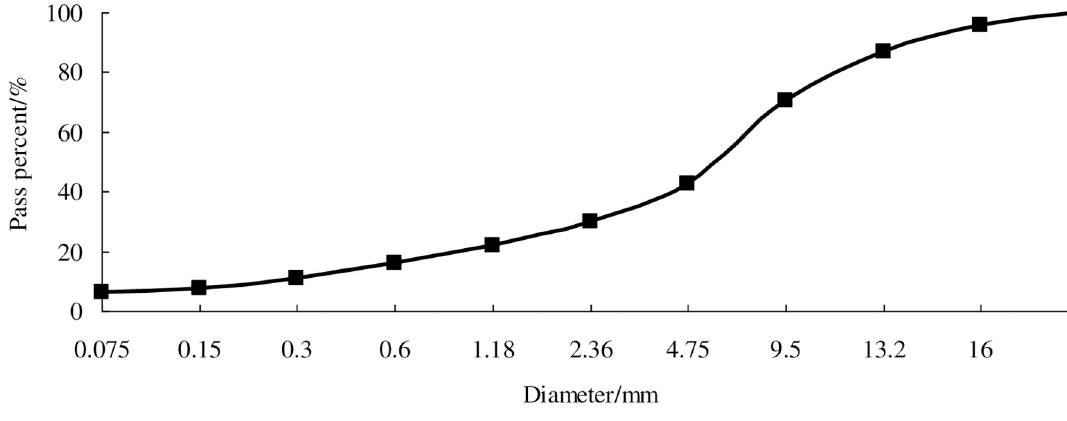
Fig 5. Aggregate